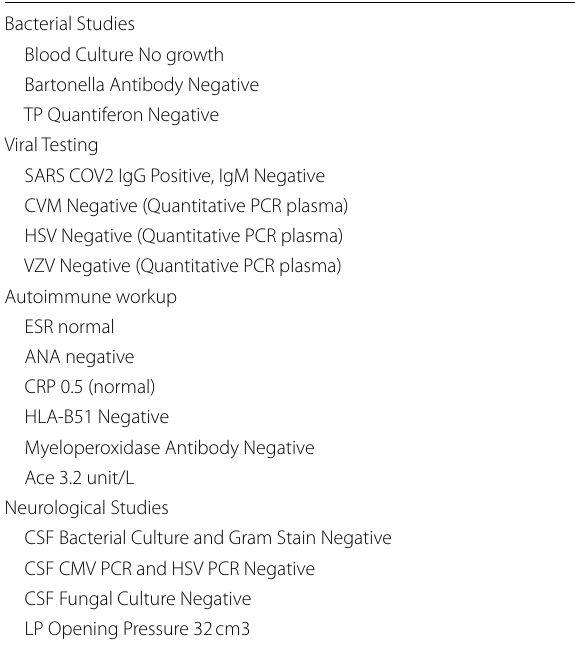
Table 2 Summary of laboratory testing and results Bacterial Studies